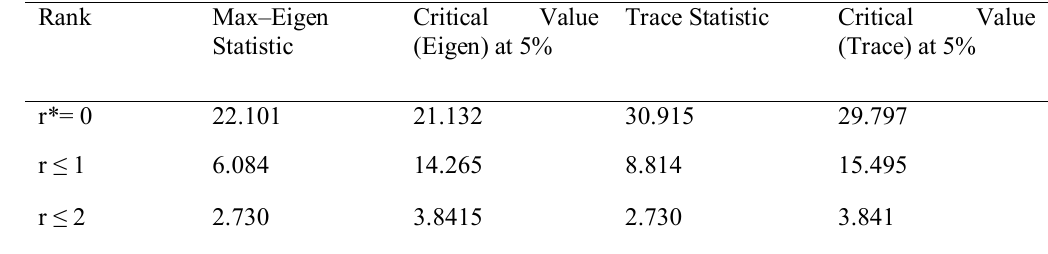
Table 2: Co-integration